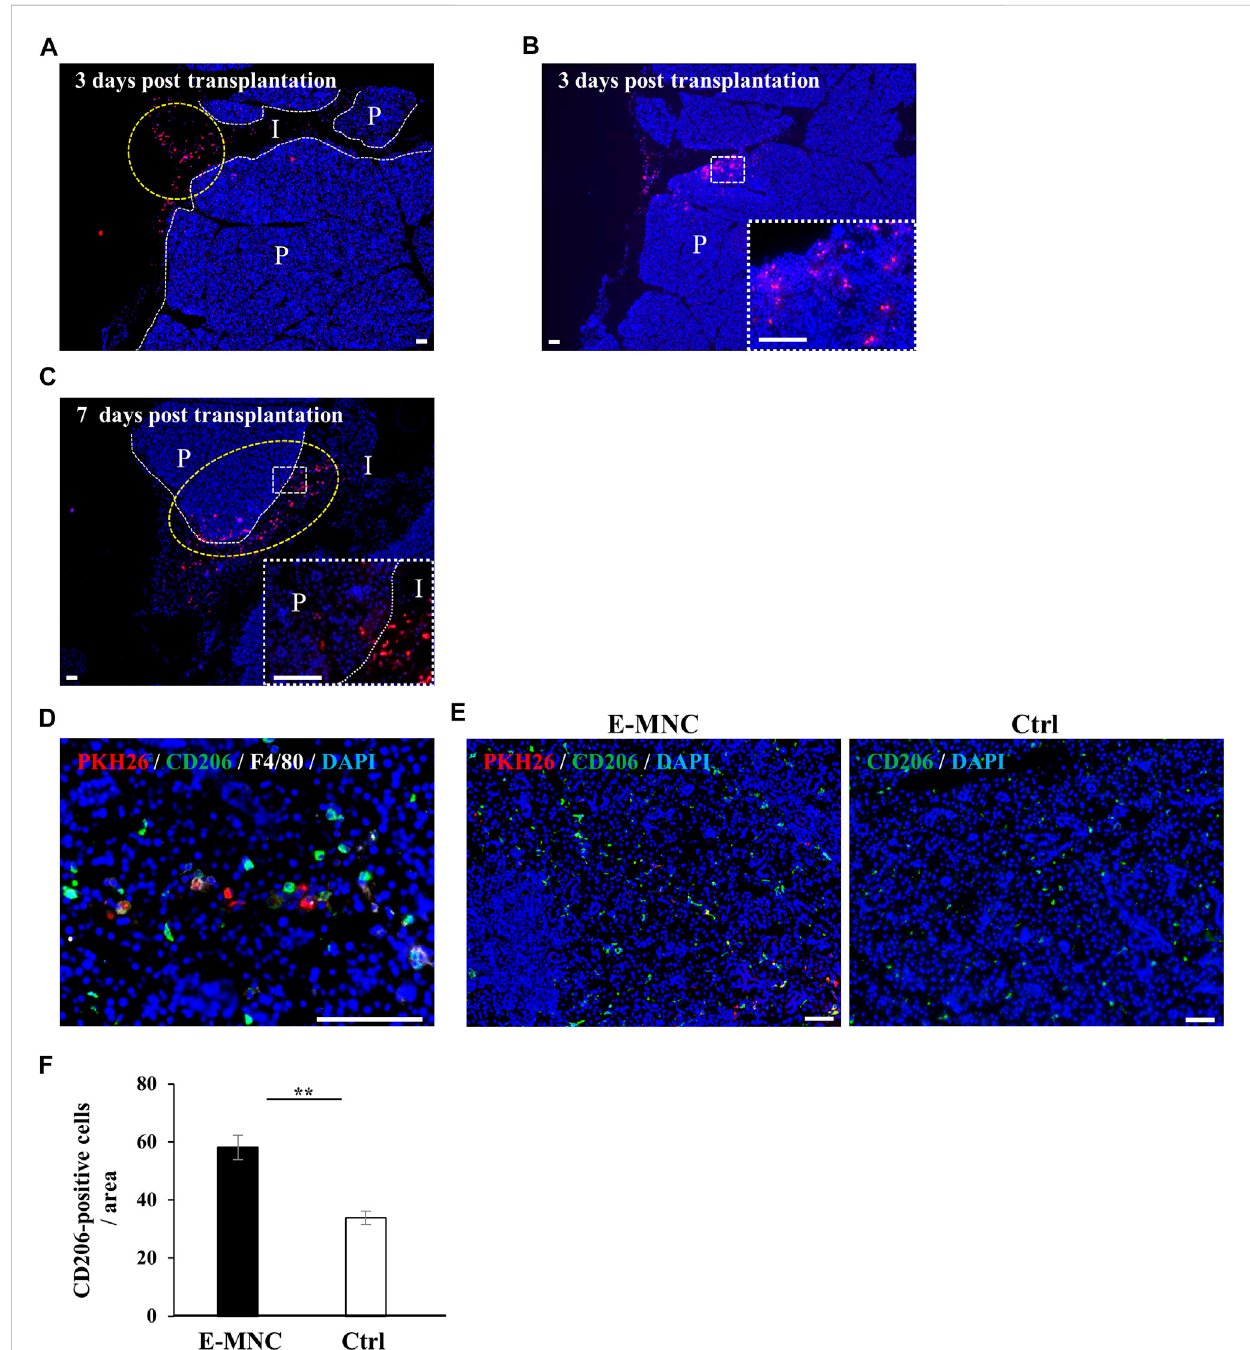
FIGURE 7 Detection of transplanted E-MNCs and M2 macrophages in submandibular glands. (A) At 3 days post-transplantation, PKH26-expressing E-MNCs (red)weredetectedintheinterlobularspace(I)(yellowdottedcircle)andparenchyma(P)ofsubmandibularglands(whitedottedlines,boundarybetween interlobular area and parenchyma; red, PKH26-labeled cells; blue, DAPI; scale bar, 100 μ m). (B) At 3 days post-transplantation, PKH26-expressing E-MNCs (red) were detected in the parenchyma (P) of submandibular glands. White dotted square area was magni fi ed in the lower right panel (red, PKH26-labeled cells; blue, DAPI; scale bar, 100 μ m). (C) At 7 days post-transplantation, PKH26-expressing E-MNCs (red) migrated to the deeper interlobular space (I) and penetrated into the parenchyma (P) (yellow dotted circle) in submandibular glands. White dotted square area was magni fi ed in thelowerrightpanel(whitedottedlines,boundarybetweeninterlobularandparenchyma;red,PKH26-labeledcells;blue,DAPI;scalebar,100 μ m). (D) At 1 daypost-transplantation,PKH26-expressingE-MNCsandhost M2macrophages expressedF4/80 (white)and CD206(green) intheparenchymaofthe submandibular glands (blue, DAPI; scale bar, 100 μ m). (E) Detection of transplanted E-MNCs (red) and CD206-positive cells (green) in E-MNC-treated glands (left image) and non-treated glands (right image) (blue, DAPI; scale bar, 50 μ m). (F) Number of CD206-positive cells/ fi eld (×200) in the parenchyma of submandibular gland tissues in E-MNC-treated glands (E-MNC) and non-treated glands (Ctrl) at 7 days post-transplantation (** p < 0.01). For statistical analysis, the Student ’ s t-test was used to analyze differences between E-MNC-group and